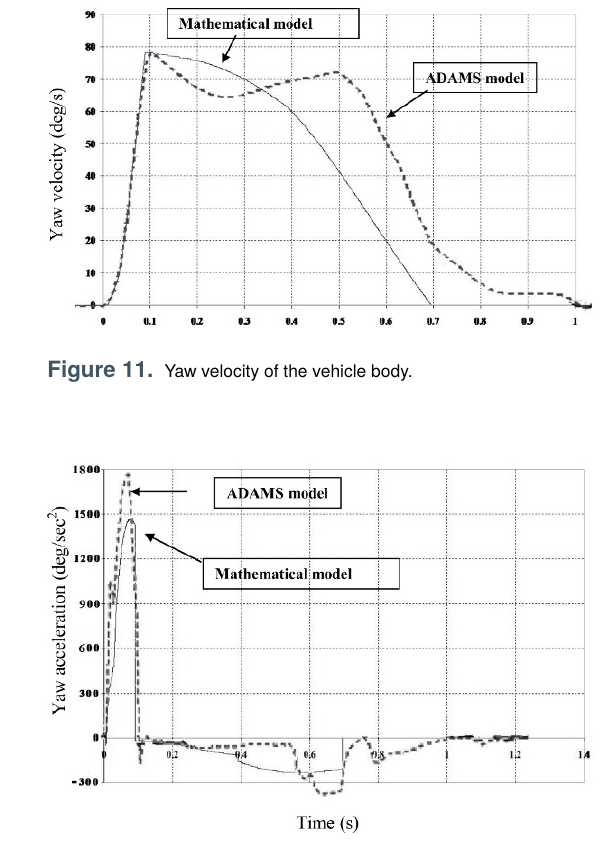
Figure 12. Yaw acceleration of the vehicle body.